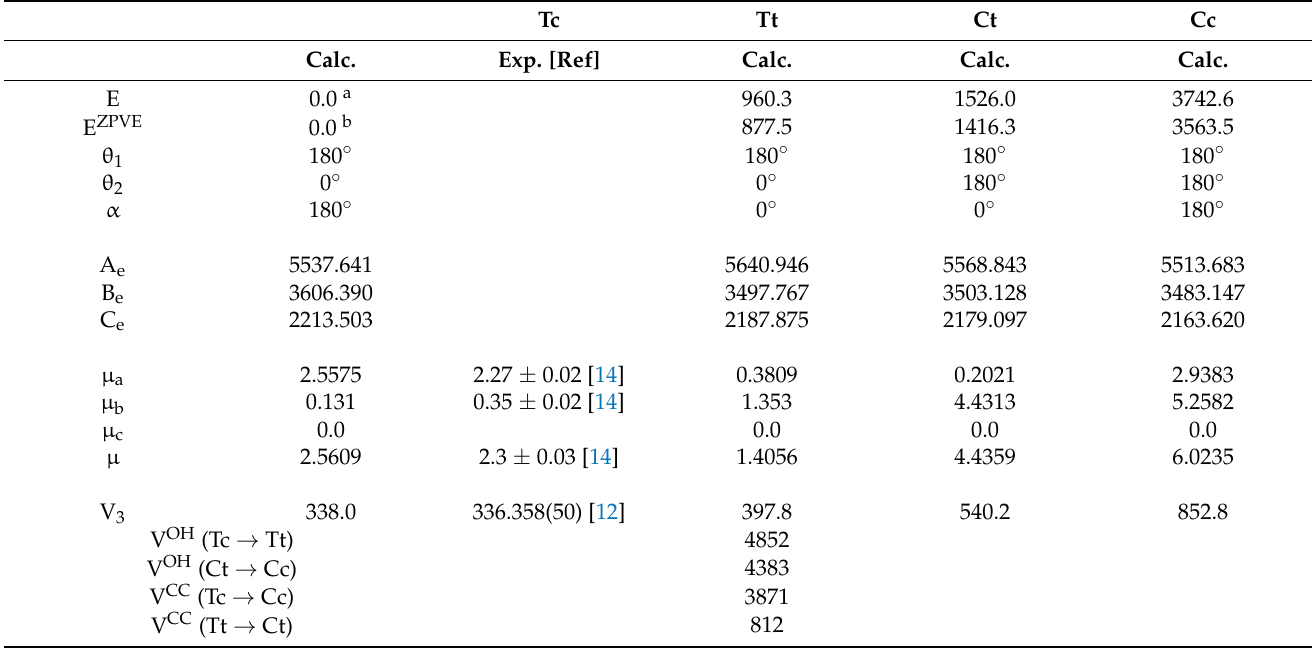
Table 1. CCSD(T)-F12/AVTZ-F12 relative energies (E, E ZPVE , in cm − 1 ), internal rotation barriers (V 3 , V OH , V CC in cm − 1 ), and equilibrium rotational constants (in MHz); MP2/AVTZ dipole moment (in D) of pyruvic acid.